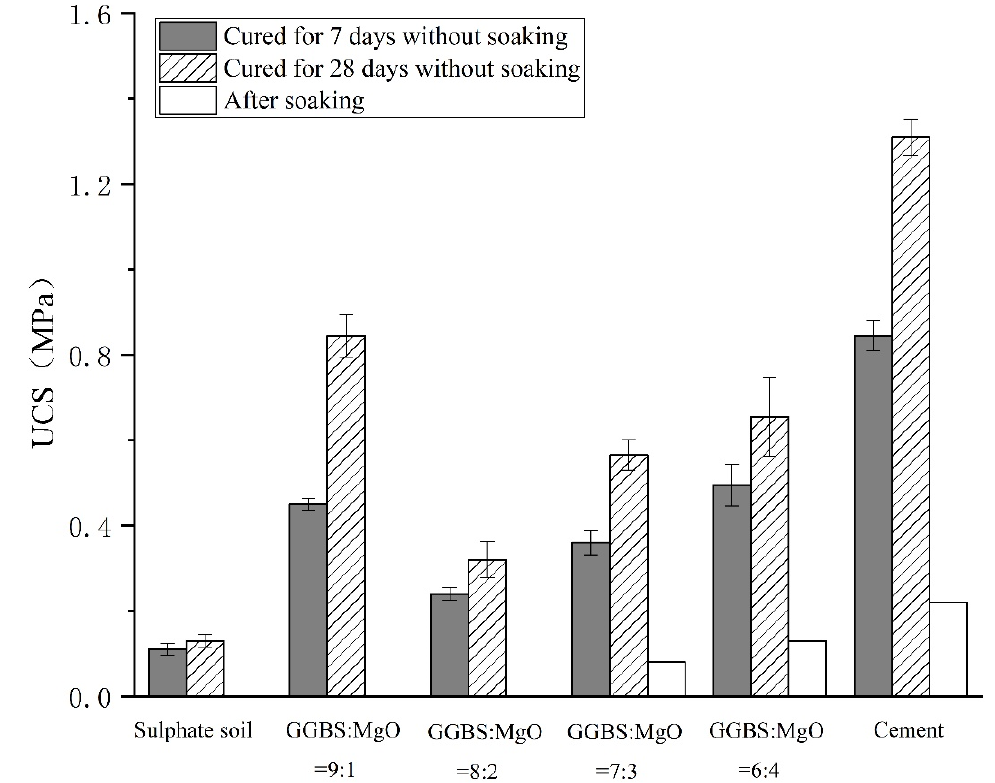
Figure 7. UCS of treated Mg-sulfate-soil at different curing and soaking stages.